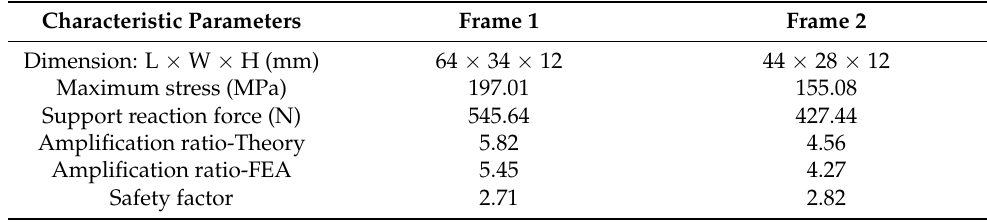
Table 7. Characteristic parameters of a single rhombus frame.